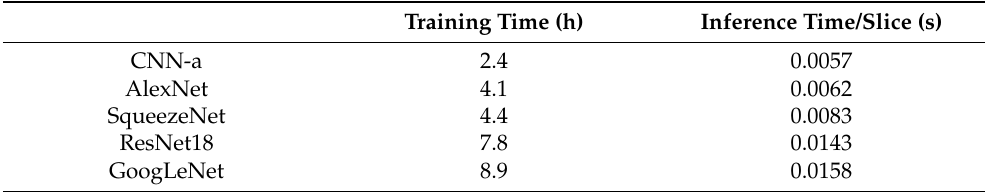
Table 5. Training times, in hours, needed for each CNN after threefold cross-validation and mean inference time (in seconds) needed to classify each